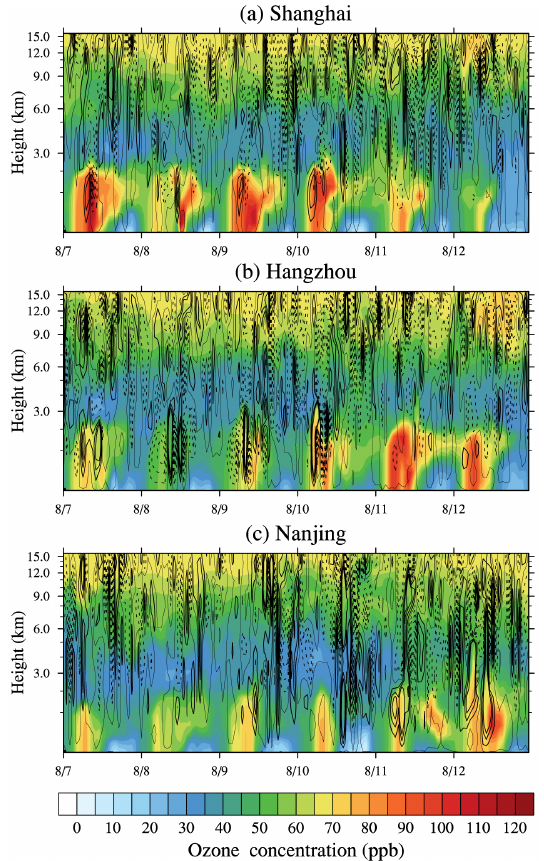
Figure 8. Temporal variations of the vertical wind velocity and the vertical distribution of O 3 concentrations above (a) Shanghai, (b) Hangzhou and (c) Nanjing from 7 to 12 August 2013. The dot- ted lines show the negative wind speeds and represent the down- ward airflows, while the solid lines show the positive wind speeds and zero vertical velocity. The interval is 0.005ms − 1